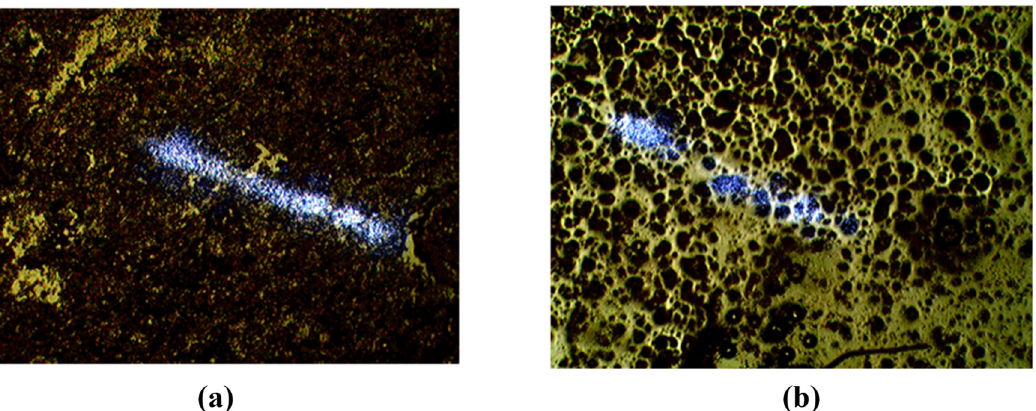
Figure 16: Optical microscopic images of PMMA + NaY 0.88 F 4 :Yb 3 + 0.1 Tm 3 + 0.02 nanocomposite fi lm made by open - air CMBMT - PLD and heated at ∼ 90°C at magni fi cation ( a ) × 40 and ( b ) × 100. The fi lm was illuminated with a 200 mW 980 nm laser. Blue strip is produced by up - conversion emission of the embedded phosphor nanoparticles initiated by the infrared pump.